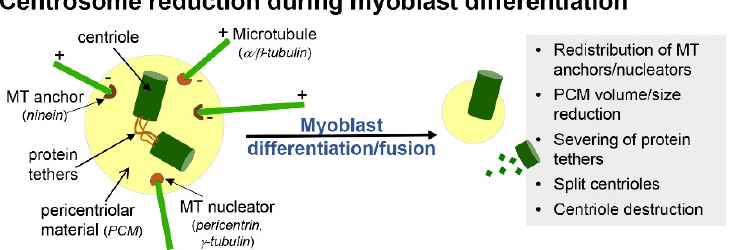
Figure 2. Centrosome reduction during myoblast differentiation. The inactivation of and reduction in centrosomes, which serve as basal bodies for cilia, accompany the terminal differentiation of myoblasts and fusion into myotubes. Centrosome volumes are reduced and pericentriolar material, comprising microtubule anchoring/nucleating complexes, are redistributed to other cellular compartments. In addition, proteins that tether centriole pairs are severed, and centriole barrels are disassembled.